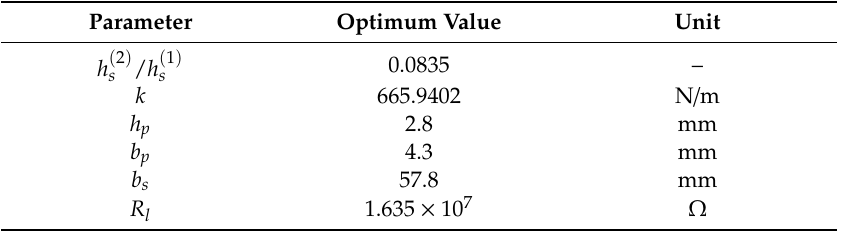
Table 8. Optimal values of the physical and geometrical parameters of the